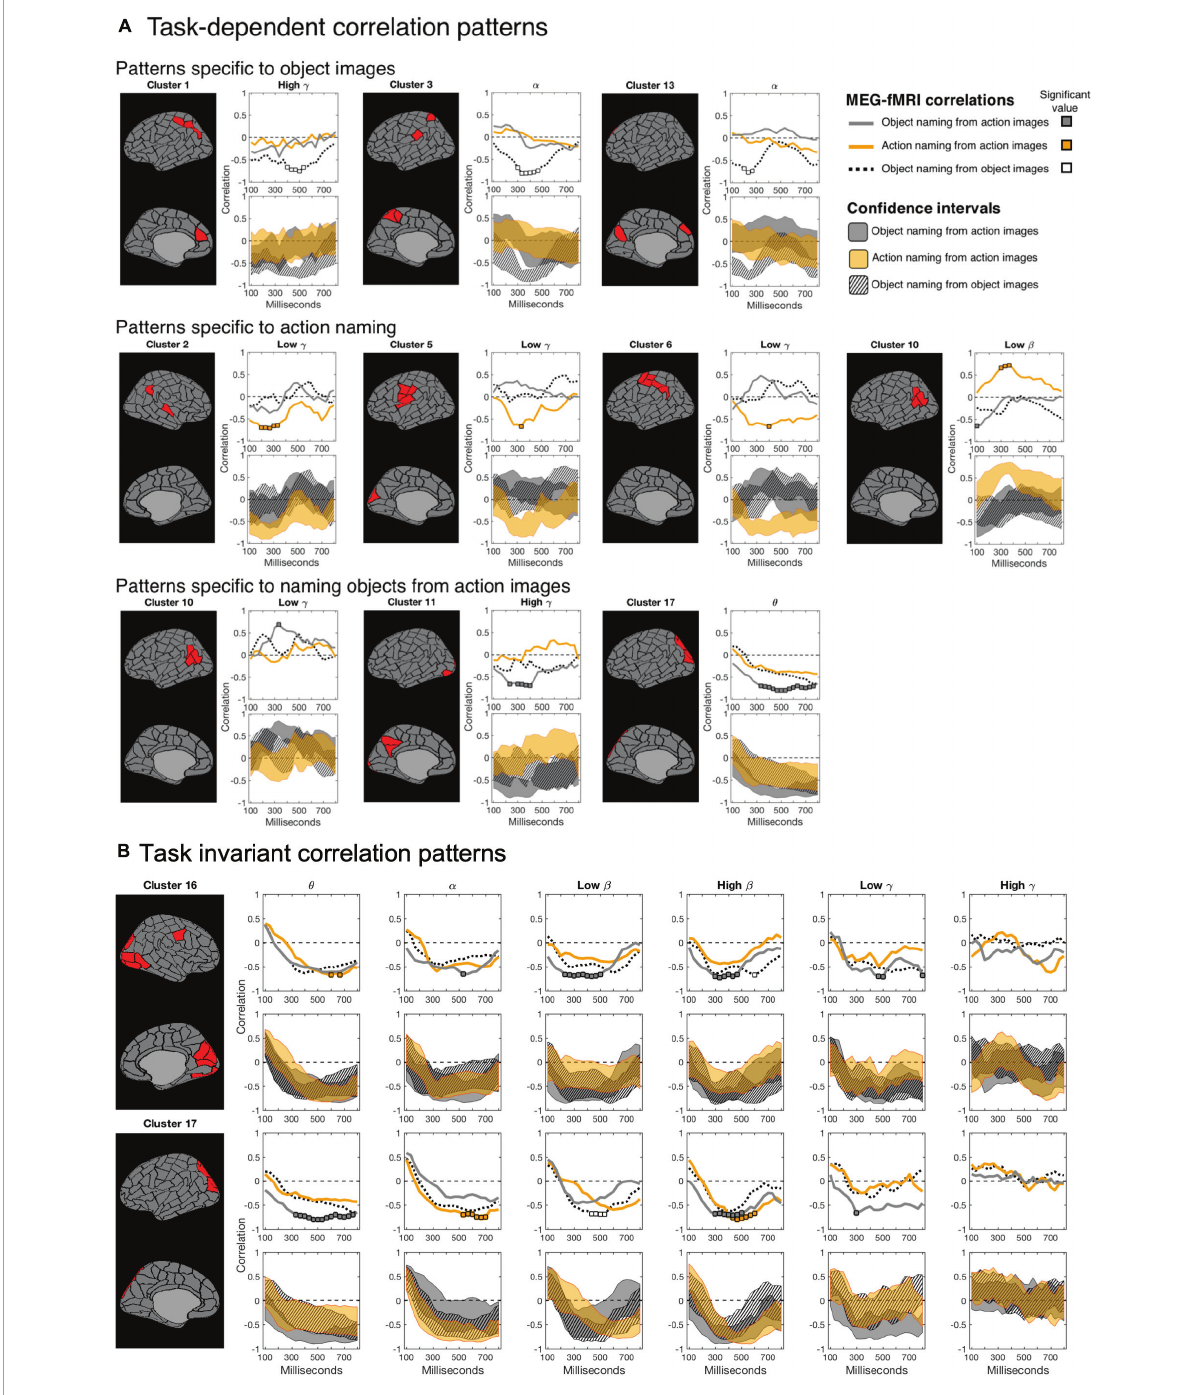
FIGURE5 Magnetoencephalography-functional magnetic resonance imaging correlation as a function of time. For each cluster, the top row shows the correlation spectra for all tasks (naming object from action pictures in gray; naming actions in orange; and naming objects from object pictures in dotted black), and the bottom row the 99% confidence intervals for the three tasks (correspondingly gray, orange and a striped black pattern). In the correlation spectra, the colored squares indicate time instances at which the correlation is significant ( p = 0.05, Bonferroni-corrected over time). (A) Task-dependent instances : One task shows significant correlation and differs from the other two tasks (non-overlapping confidence bounds) at a given time. White areas between the confidence intervals of experimental conditions indicate time instances of significantly different MEG-fMRI correlation between two or more conditions ( p = 0.01, uncorrected). (B) Task-invariant instances : Clusters 16 and 17 suggest consistent negative correlation between MEG and fMRI at lower frequencies, among all experimental conditions, in the occipital